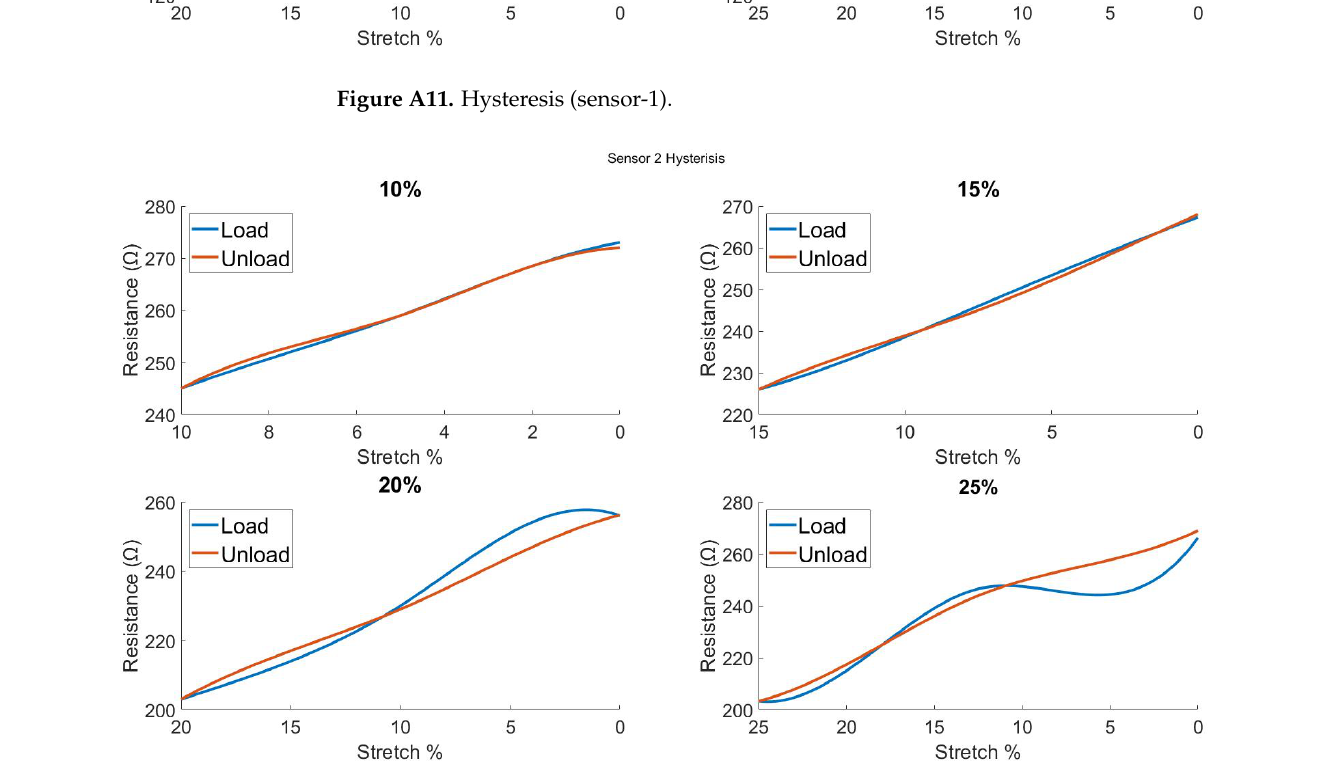
Figure A12. Hysteresis